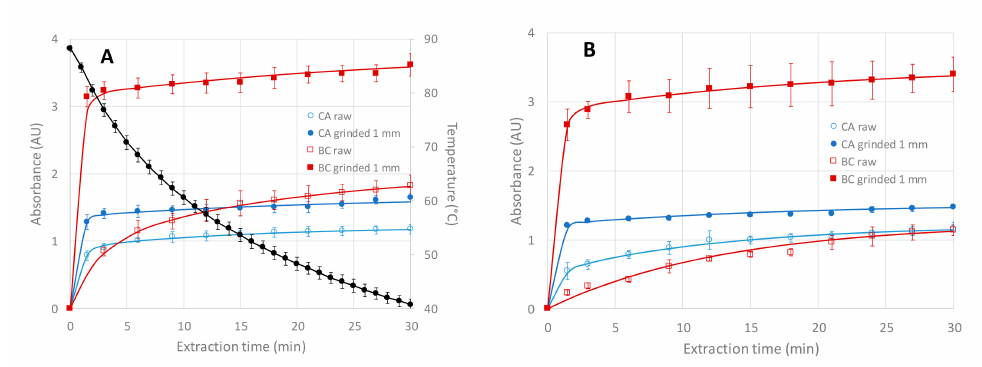
Figure 1. Kinetics of extraction of Chrysanthellum americanum (CA, lot no. 559980) and blackcurrant (BC, lot no. 55870) monitored by UV absorbance at 198 nm. ( A ) Infusion mode at 500 rpm stirring speed with the temperature profile (in black). ( B ) Maceration mode at 500 rpm stirring speed and at 60 ◦ C. A total of 2.5 g of plant material in 250 mL water was systematically used. In total, 100 µ L of the solution was taken and added to 4 mL water before each UV measurement. If the absorbance values were above 1.7, dilution in 8 mL water (instead of 4 mL) was performed, but the experimental values were multiplied by 2 to allow for a comparison with dilutions in 4 mL. Error bars are ± 1 SD on n = 3 repetitions of independent extractions. For ground materials, 1 mm grinder was used (see Section